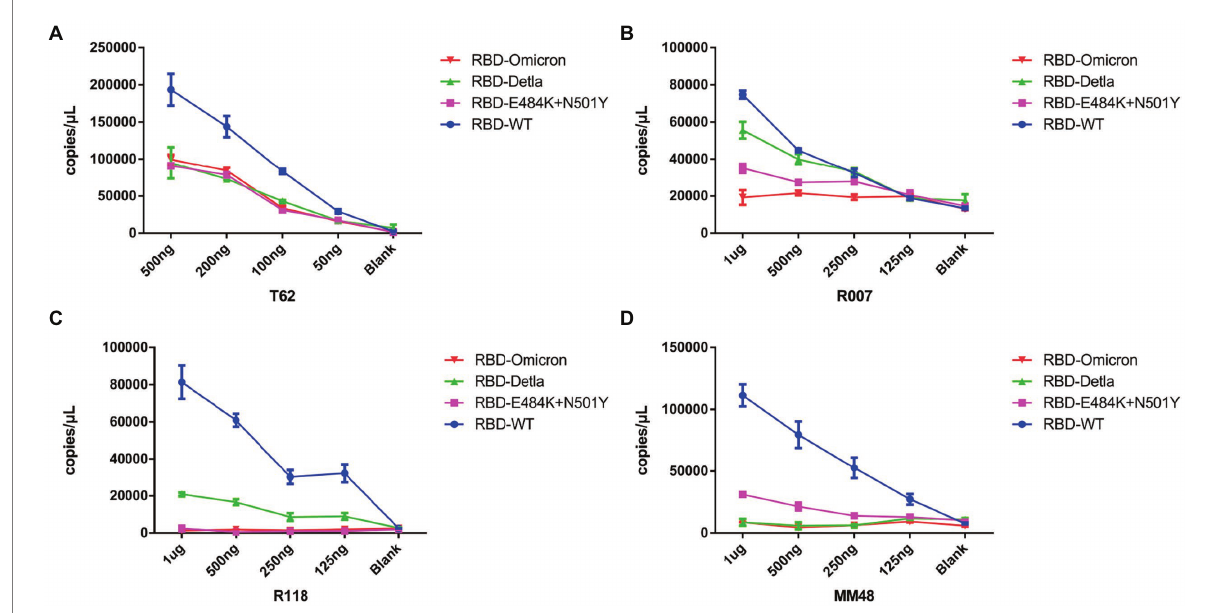
FIGURE 5 Pi-mqPCR assay to explore the enrichment of the recombinant phage-displayed RBD constructs from wild-type SARS-CoV-2 and different variants by a polyclonal antibody (A) and three monoclonal antibodies (B–D) . The values shown are the average of three independent experiments and their standard errors.